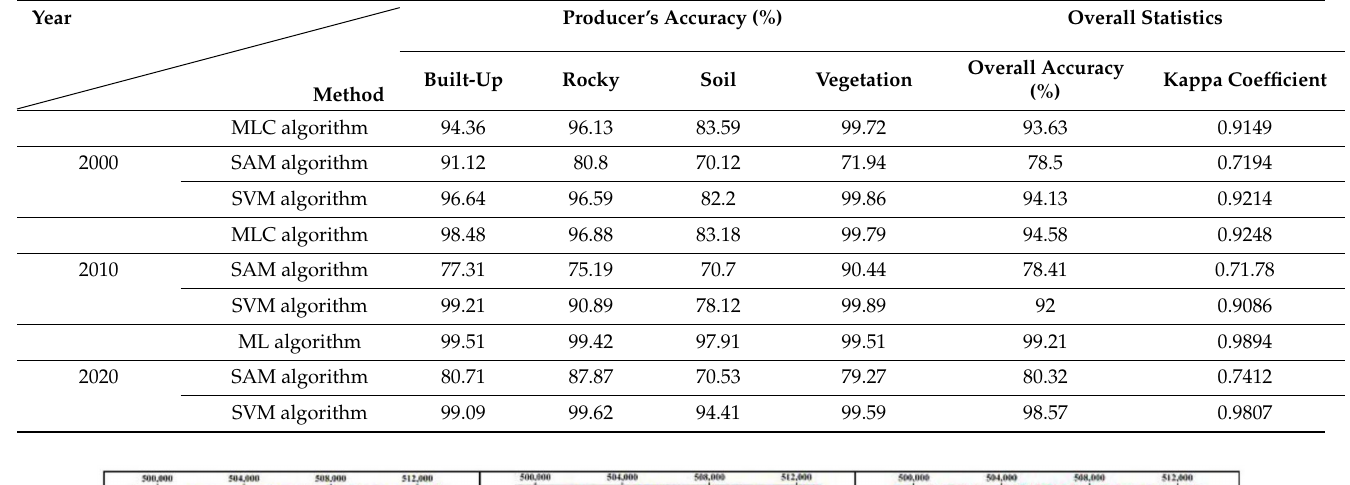
Table 1. Evaluating classification accuracy.